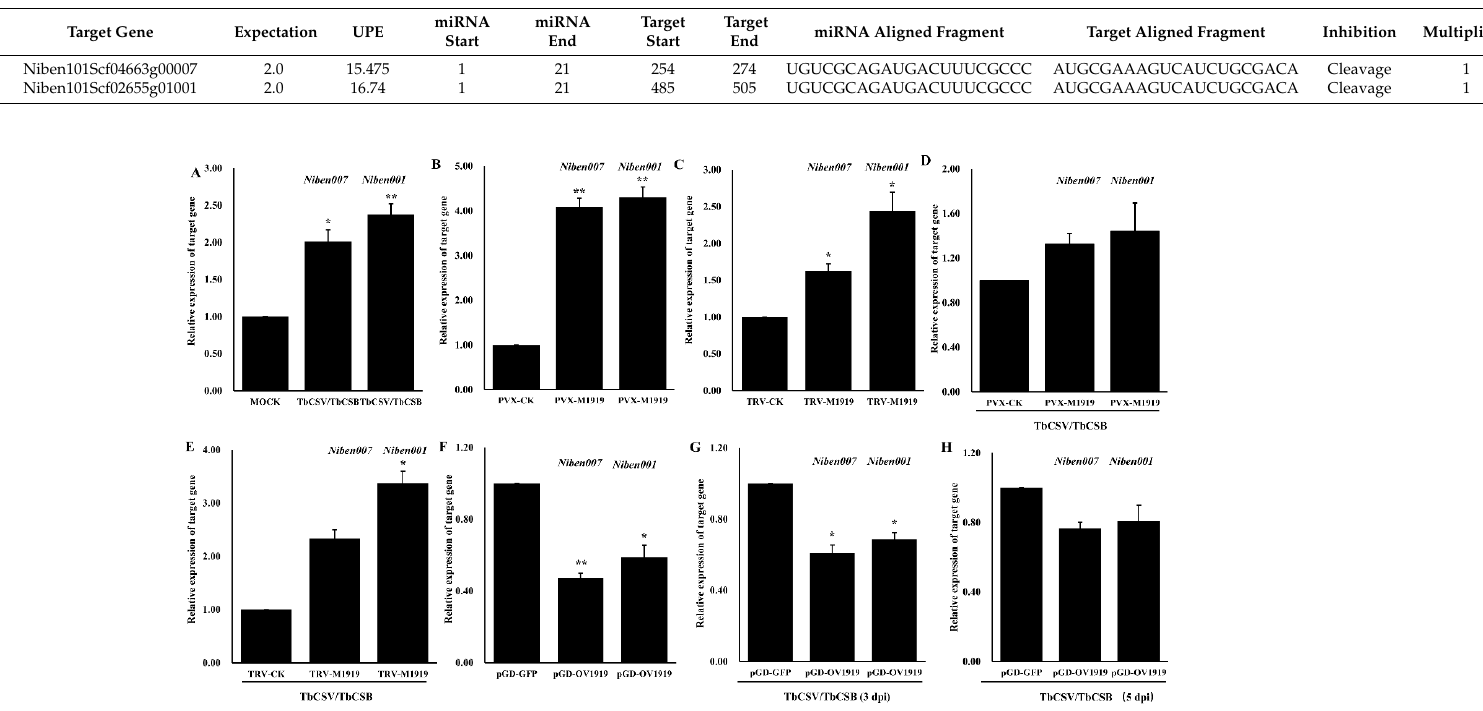
Table 1. Predictions of nbe-miR1919c-5p targeted N. benthamiana genes.